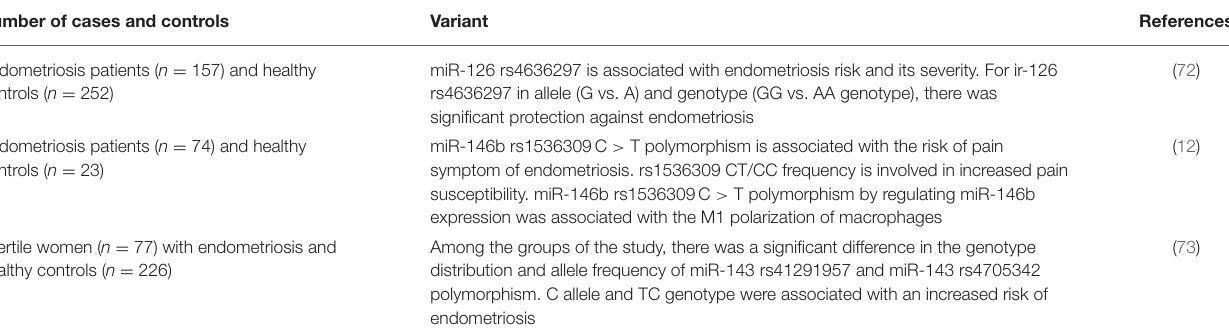
TABLE 4 | Association between polymorphisms with SNPs and risk of endometriosis. Number of cases and